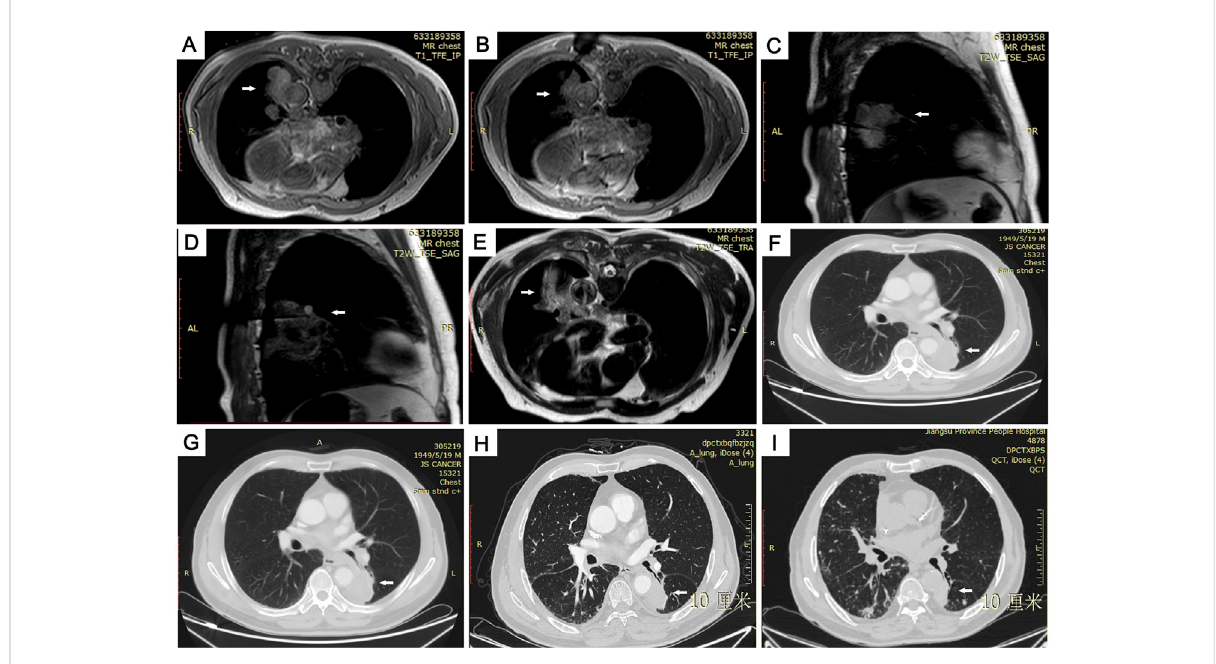
FIGURE 4 Images from 72-year-old man with 50 × 36 mm primary pulmonary adenocarcinoma in lower lobe of left lung. (A) Preoperative MRI scan and external puncture site location. (B) Ablation needle puncture reached the center of the lesion. (C,D) Due to the large lesion, a second ablation was performed by adjusting the ablation needle in real time under the sagittal image. (E) T2WI MRI scan immediately after the operation showing the surrounding ring-shaped high-signal thermal-injury response zone completely covered the ablation area with low signal and was well demarcated from the adjacent abdominal aorta. (F – I) Follow-up CT images showing the ablative zone was gradually shrinking at postoperative months 3 (F) 6 (G) 12 (H) and 16 (I) .